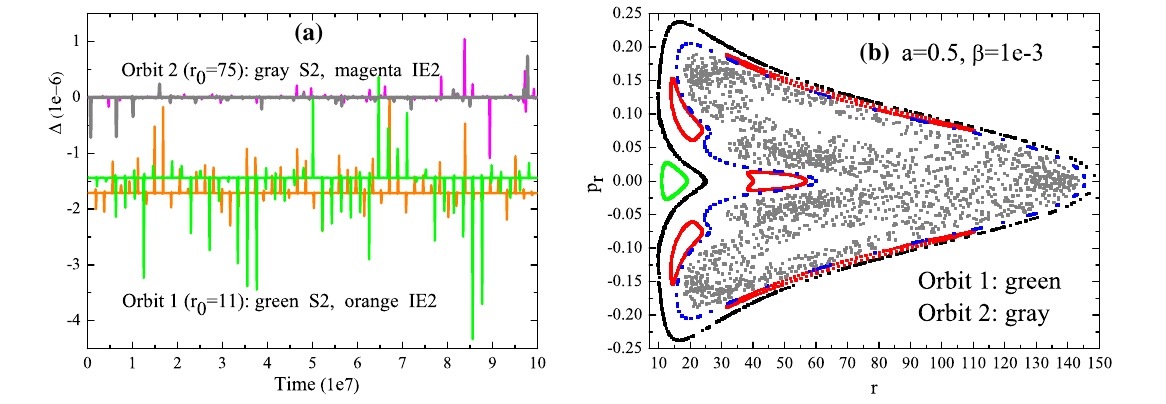
a proper time step for IE2 and a new coordinate time step for S2. Both algorithms make the errors have no secular drift and remain of the same order for Orbits 1 and 2. b Poincaré sections on the plane θ = π/ 2 and p θ > 0, given by S2. It is clear that Orbit 1 is regular, whereas Orbit 2 is